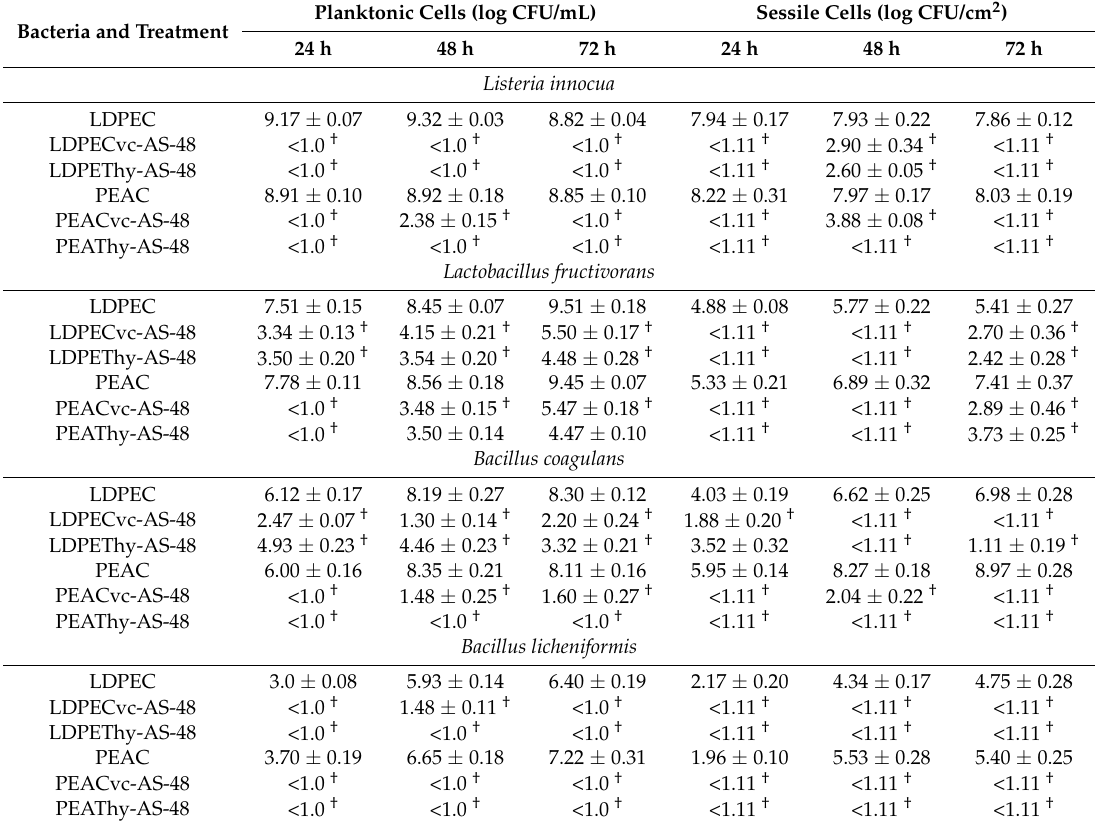
Table 1. Effect of plastic films activated with carvacrol or thymol in combination with enterocin AS-48 on the concentrations of viable planktonic and sessile